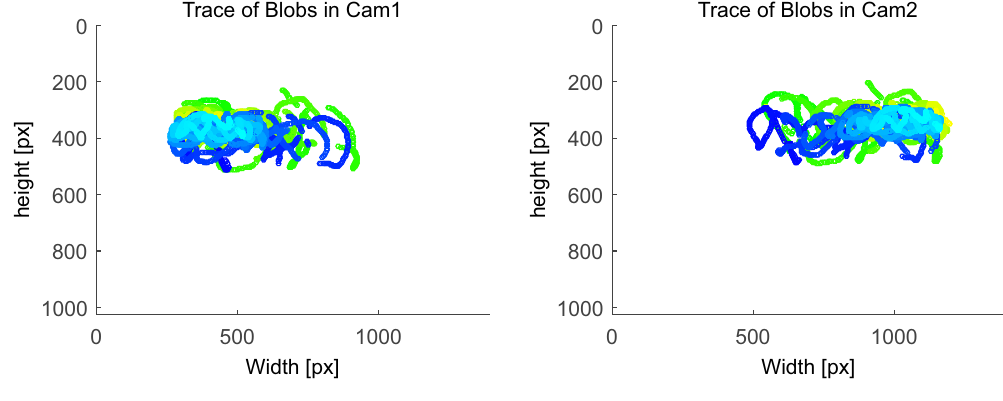
Figure 26. Calibration with d base ≈ 6